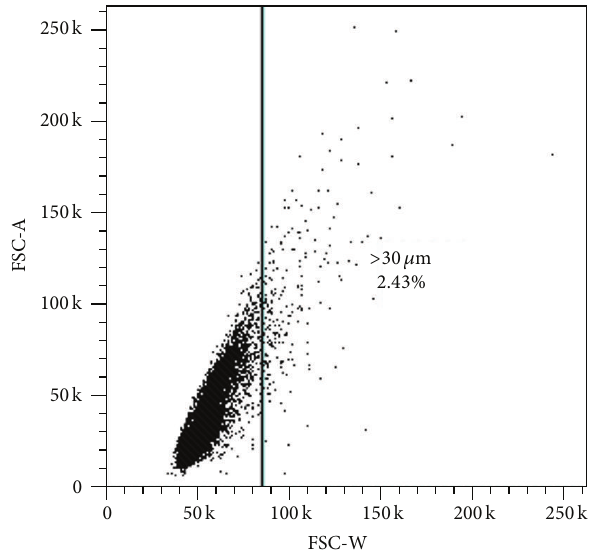
Figure 1: Gating of cell clumps or large cells > 30 𝜇 m. After the exclusionofdebris,FSC-WwasplottedagainstFSC-Aandcalibrated using standardized polystyrene